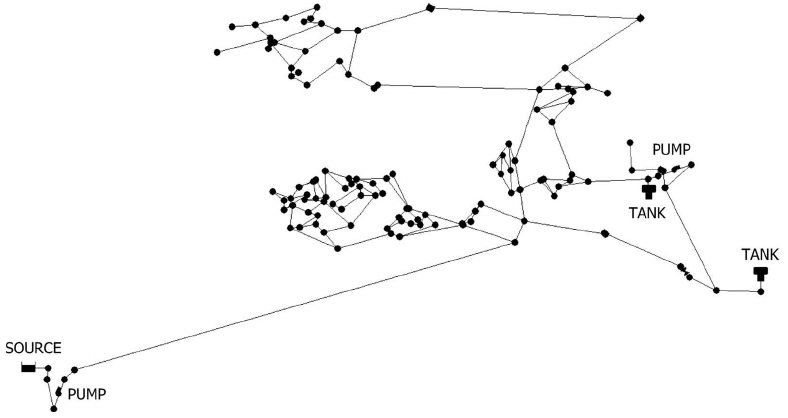
Figure 3. The network researched in the experiment.